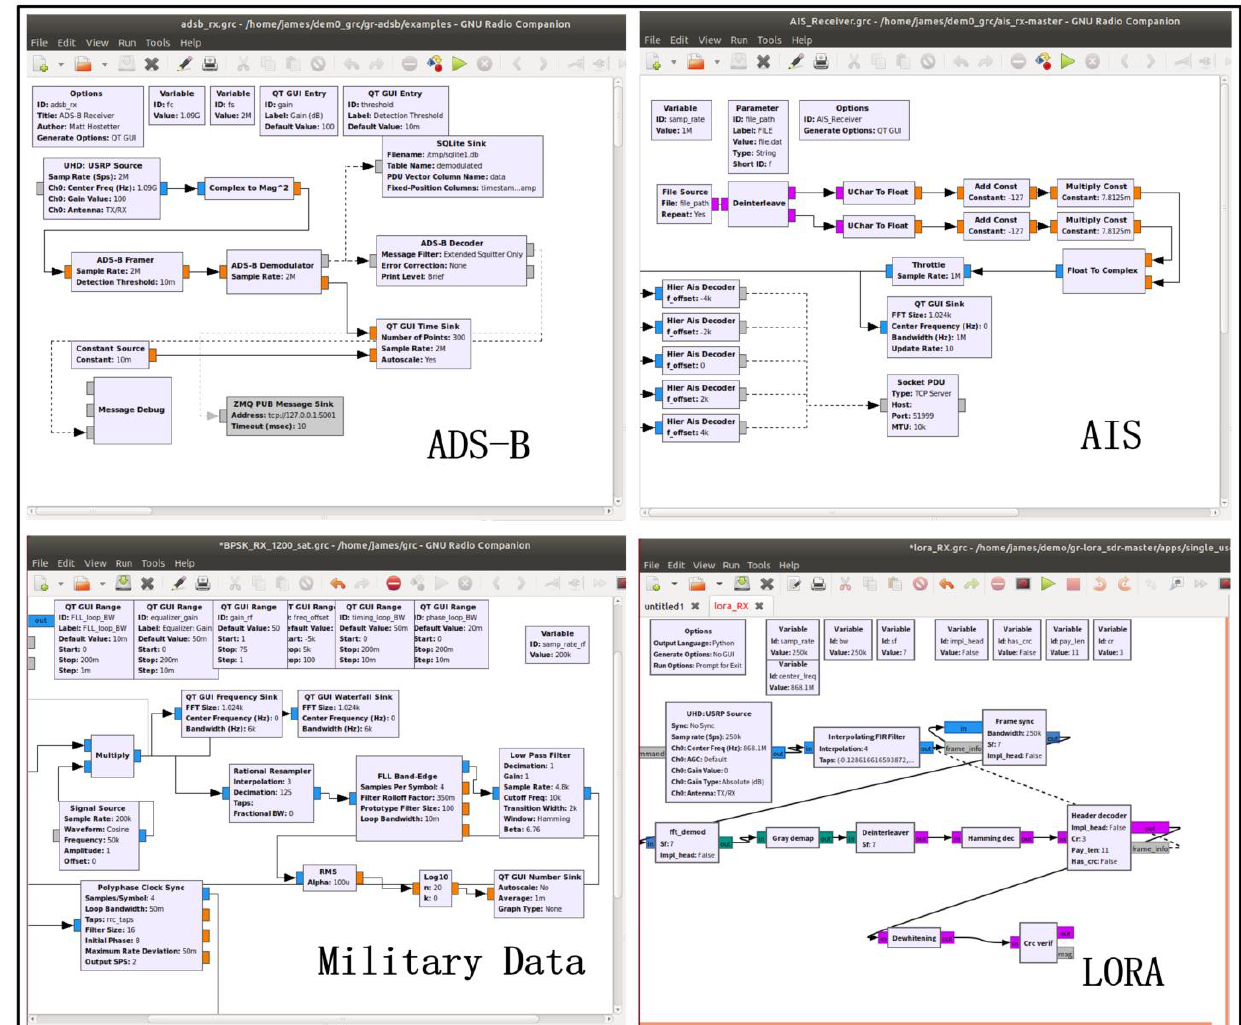
Figure 9. Different DCS flow design.